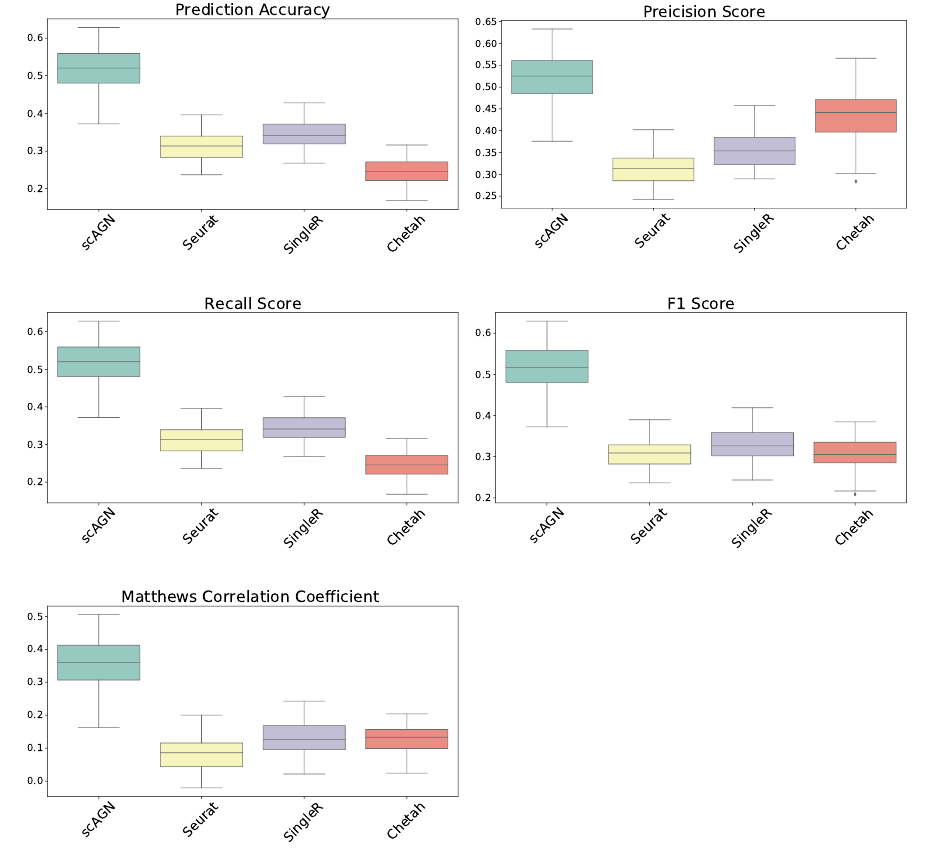
Figure 5. Boxplot to illustrate the performance of scAGN against other methods using simulated datasets with a sparsity of 95% when classes are imbalanced in the dataset. scAGN has superior performance compared to the existing